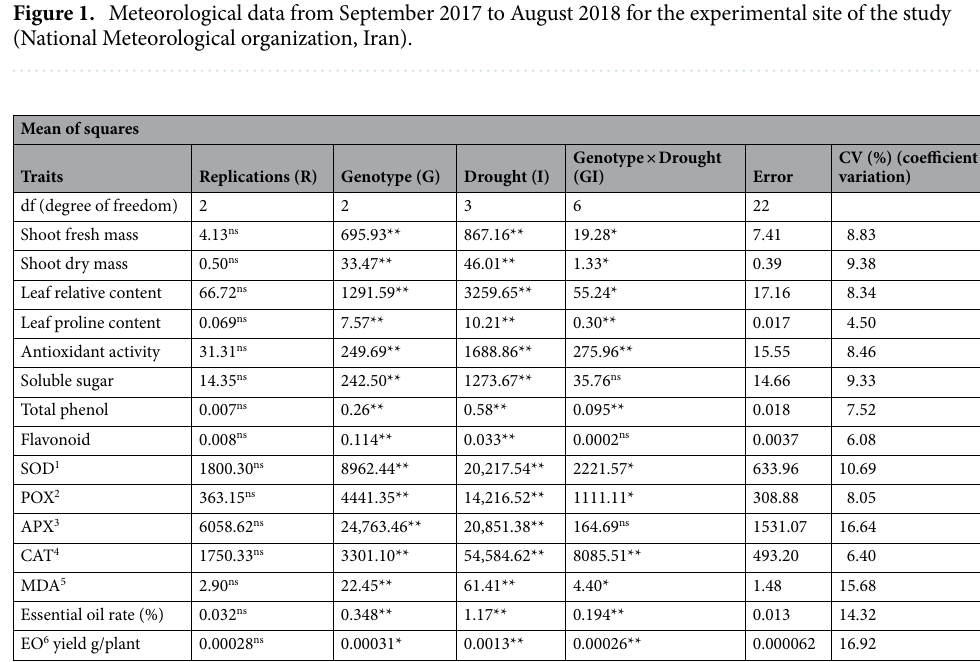
Table 2. Variance analysis of the effect of drought stress on enzymatic activity of antioxidant enzymes, and quantity of essential oil from different lavender genotypes. 1. SOD, Superoxide dismutase; 2. POX, Peroxidase; 3. APX, Ascorbate peroxidase; 4. CAT, Catalase; 5. MDA, Malondialdehyde; 6. EO, essential oil. ns No significant difference. *Significant difference at p < 0.5. **Significant difference at p <